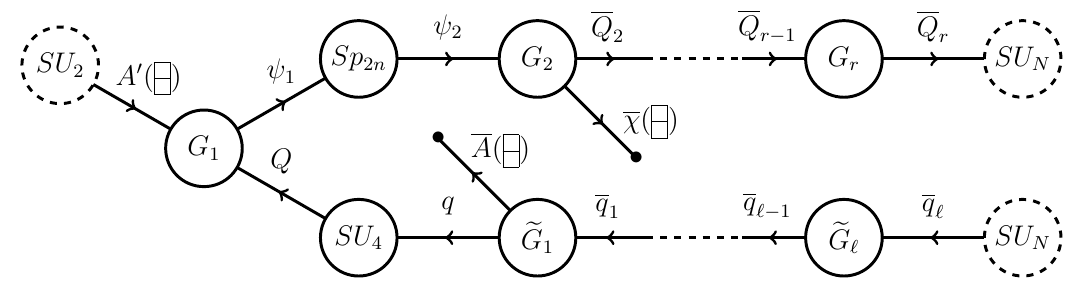
SU(4) Sp(2 n ) SU( N ) r composite axion model (cid:2) (cid:2) (cid:2) Sp(2 N 4). The SU(2) family symmetry of (cid:17) (cid:0)